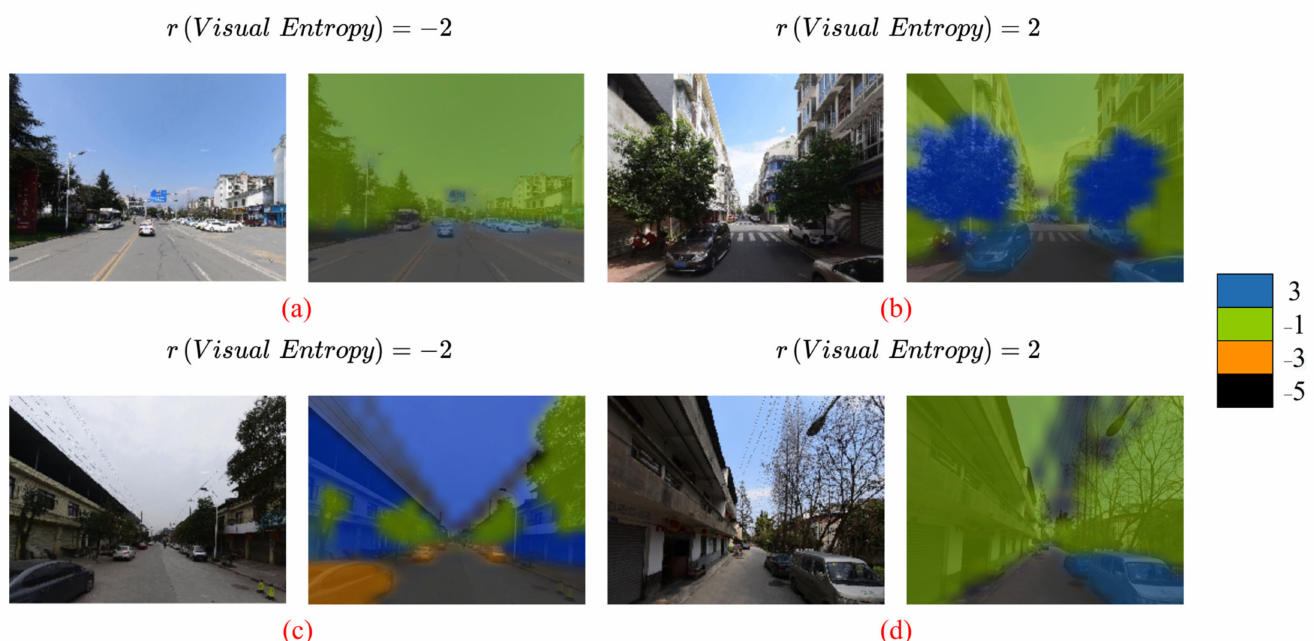
Figure 7. Visualising the expert evaluation model based on visual features for four cases. In ( a ) the label of the image is safe, and the prediction given by the model is also safe; ( b ) the label is unsafe, and the prediction is safe; ( c ) the label is safe, and the prediction is unsafe; ( d ) the label is unsafe, and the prediction is also unsafe. “r(Visual Entropy)” refers to the different rewards obtained by the feature visual entropy according to different